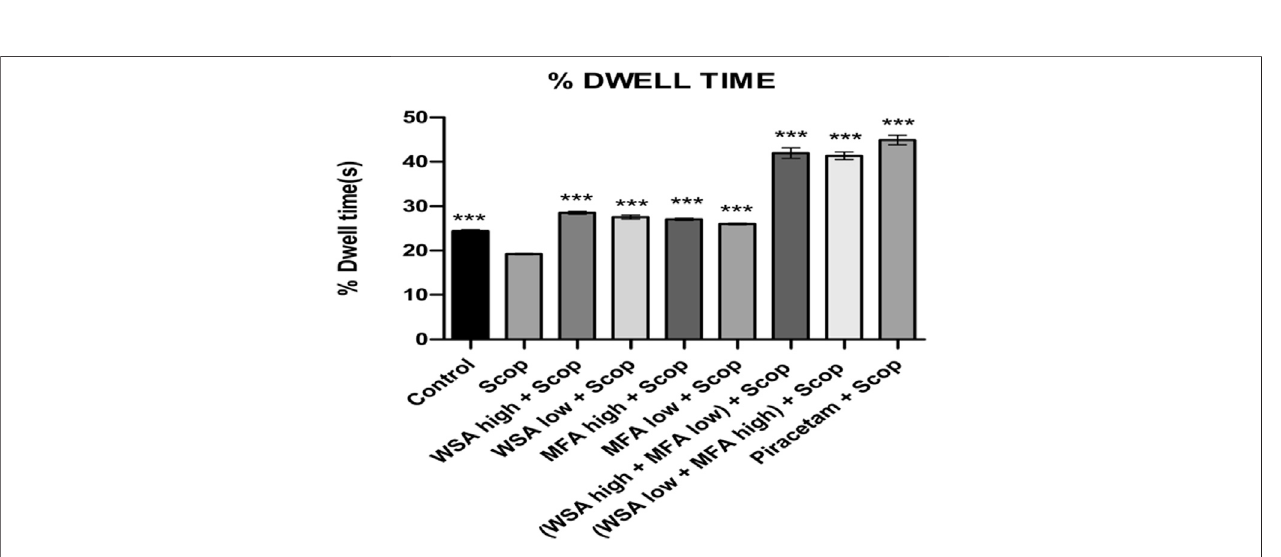
FIGURE 6 | Dynamics of percentage dwell time in the spatial acquisition trial in reference memory test in male wistar rats in Morris water maze. Each data point is markedon theday ofprobetrial and isthemean offourtrials. ThedataisrepresentedasMean ± SEM.Each lineinthe plotshows theaverageofsixmice ineach group. Markers represent the differences *** p < 0.001 when compared to Scop group; analyzed by one-way ANOVA followed by Dunnett ’ s Multiple Comparison Test.